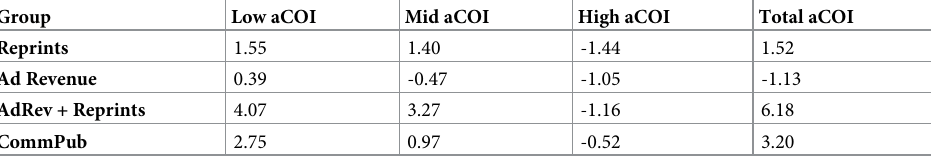
Table 3. Effect size expressed as BCa-corrected (5000 iterations) mean difference compared to the